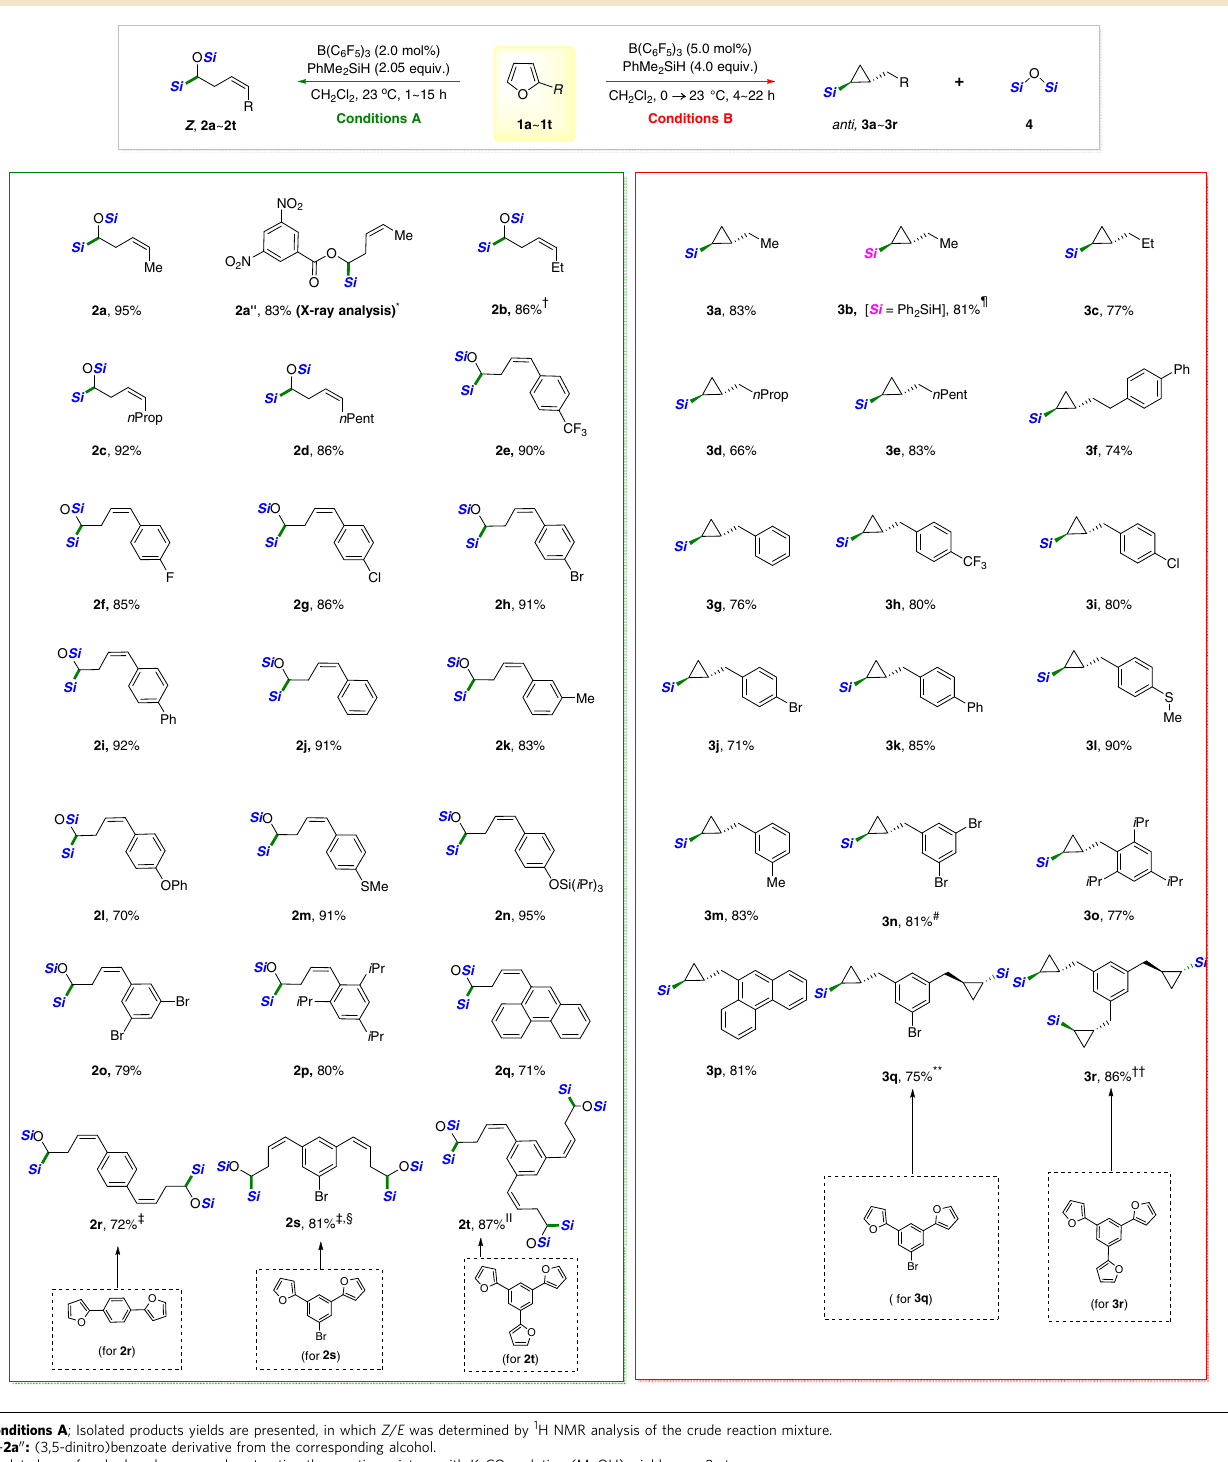
Table 1 | B(C 6 F 5 ) 3 catalysed cascade silylative transformation of